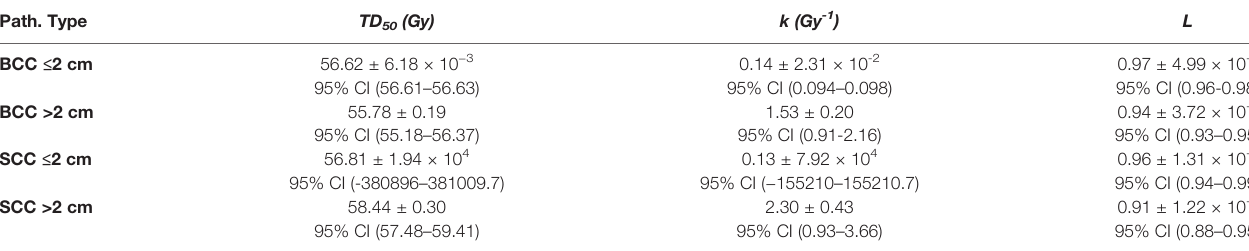
TABLE 2 | Tumor control probability (TCP) model parameters for basal and cutaneous squamous cell carcinomas (BCC and cSCC, respectively) tumors of size ≤ 2 and >2 cm. Path. Type